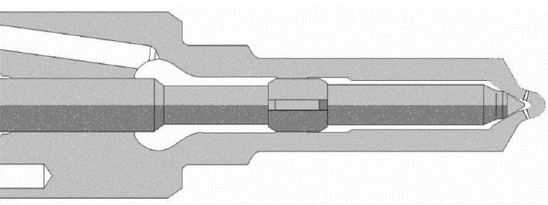
Figure 1. Model of test nozzle geometry.